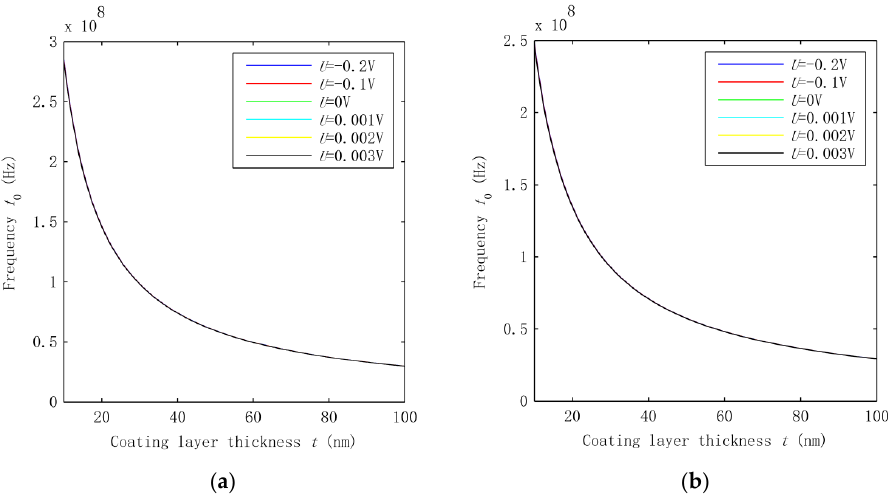
Figure 4. Frequencies calculated without considering the interphase vdW interaction for the HNWs where the SWCNT radius R is ( a ) 0.68 nm and ( b ) 2.51 nm, respectively.